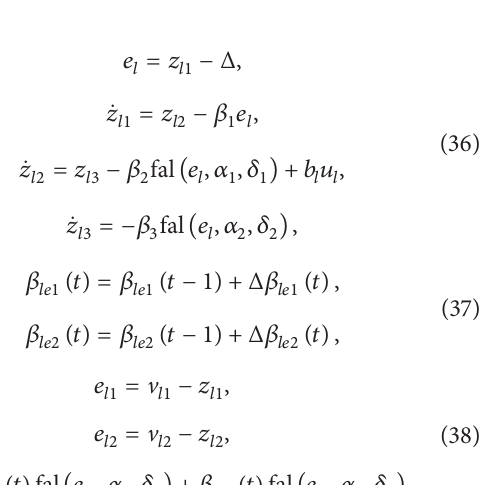
Figure 4: The result of AUV path